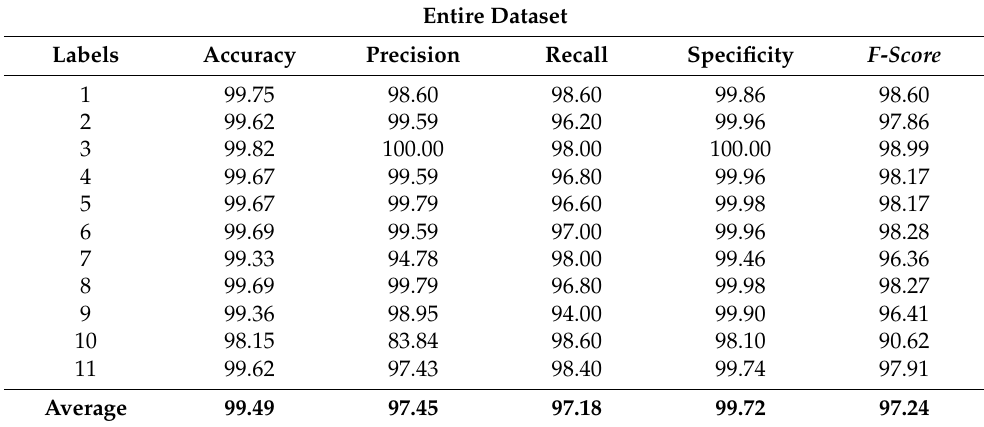
Table 2. Result analysis of PODCNN-LWID approach with distinct class labels for entire dataset.